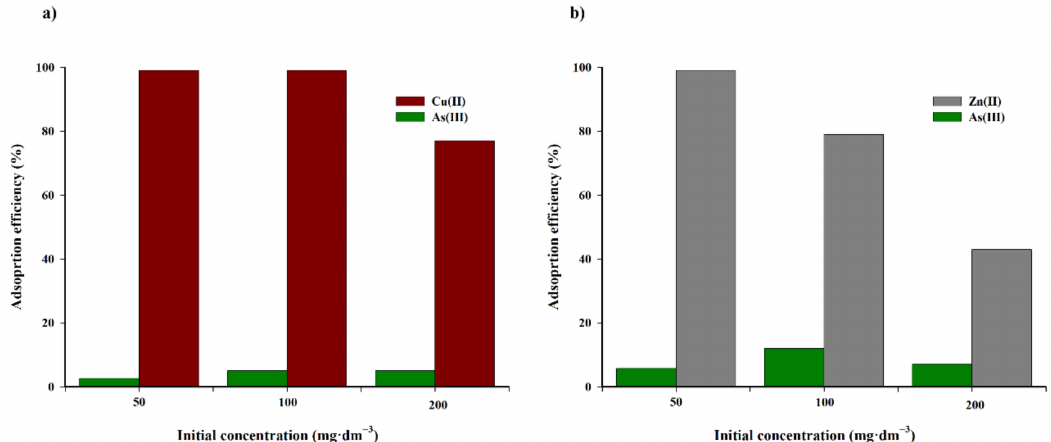
Figure 11. Effect of initial concentration on the adsorption efficiency of copper(II) ( a ), zinc(II) ( b ) and arsenic(III) ions (T = 313.15 K, t = 240 min, mass of adsorbent = 3.33 g · dm − 3 , pH = 5).